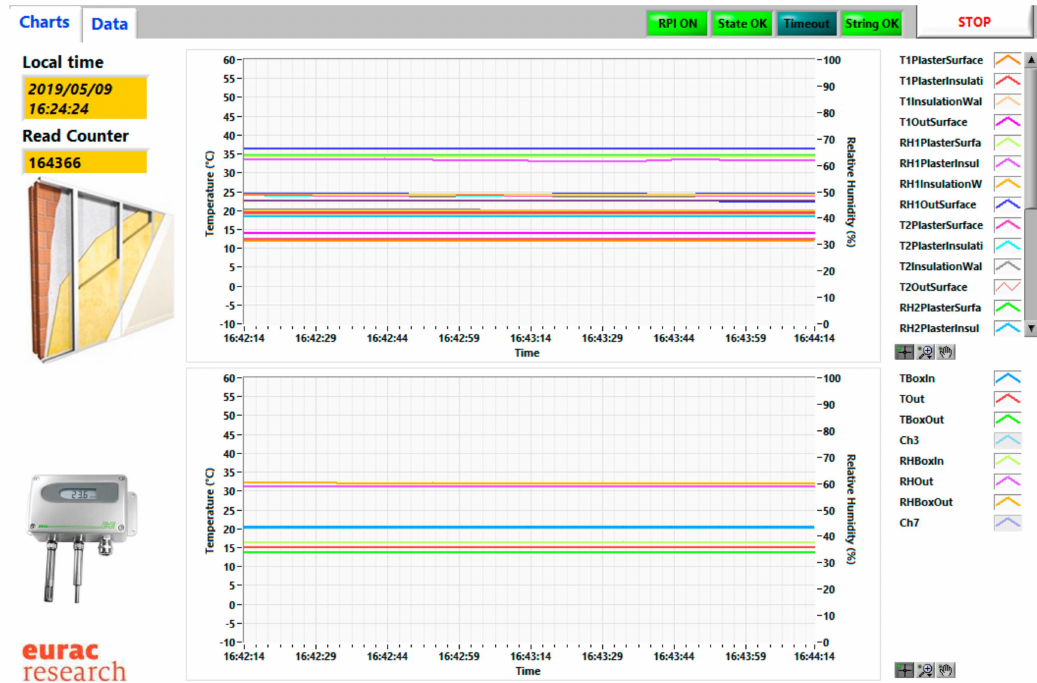
Figure 10. Data overview software: Charts section. It permits to see T and RH data. In the upper graph there are stratigraphy signals (T on the left and RH on the right). The lower graph shows environment signals from outdoor, from the room and inside the thermal box.